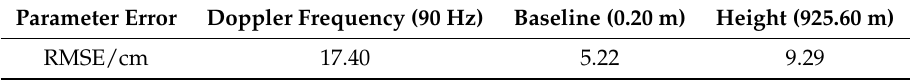
Table 3. The root mean square error (RMSE) between the corrected DInSAR phase with different parameter errors and the corrected DInSAR phase without parameter errors in distance on 20080131 and 20080317.